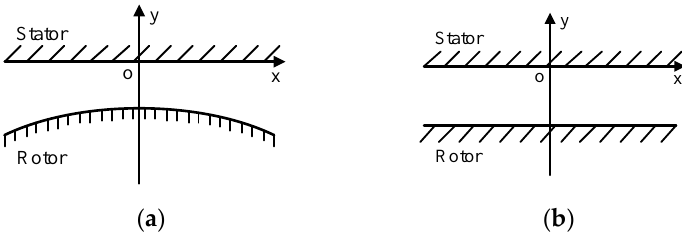
Figure 3. The category of the air gap: ( a ) non-uniform air gap; ( b ) uniform air gap.